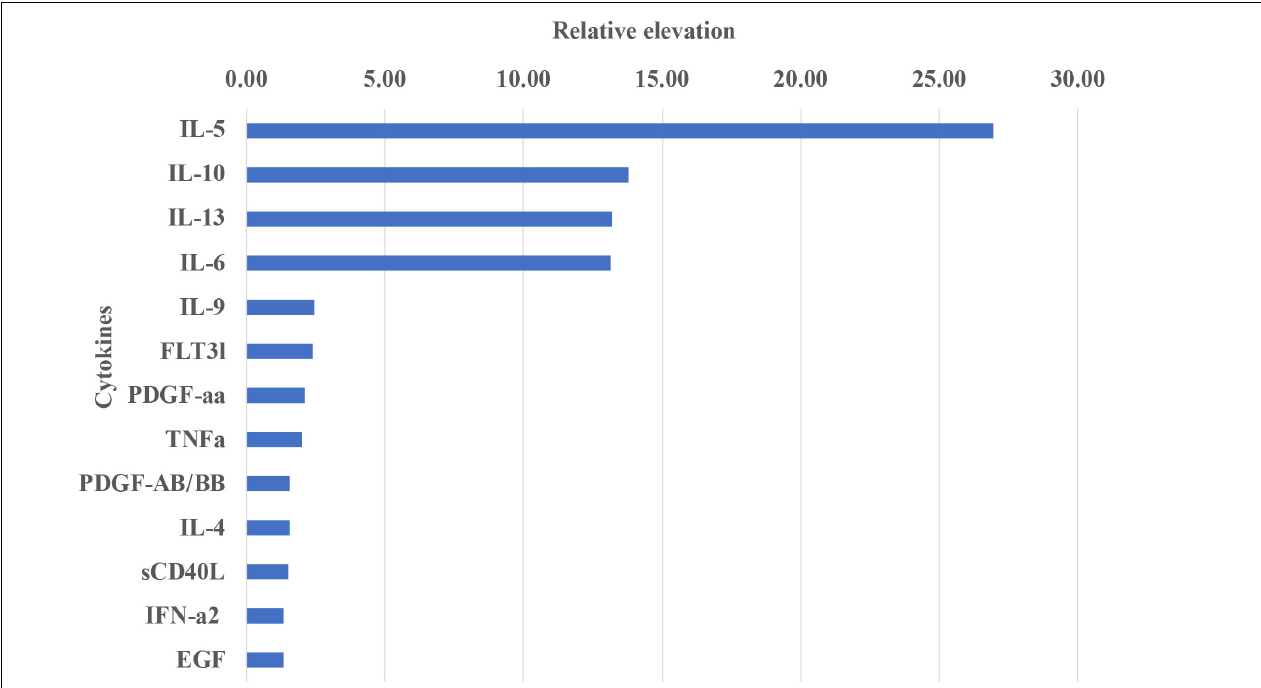
FIGURE 3 | The relative importance of individual cytokines changed in aqueous humor between OT and control groups. The vertical axis shows the individual cytokines with significant difference between OT and control group. The horizontal axis represents the average increase fold of expression levels. IL-5 showed the most noticeable expression increase, followed by IL-10, IL-13, and IL-6, which showed 13-folds or more difference between the